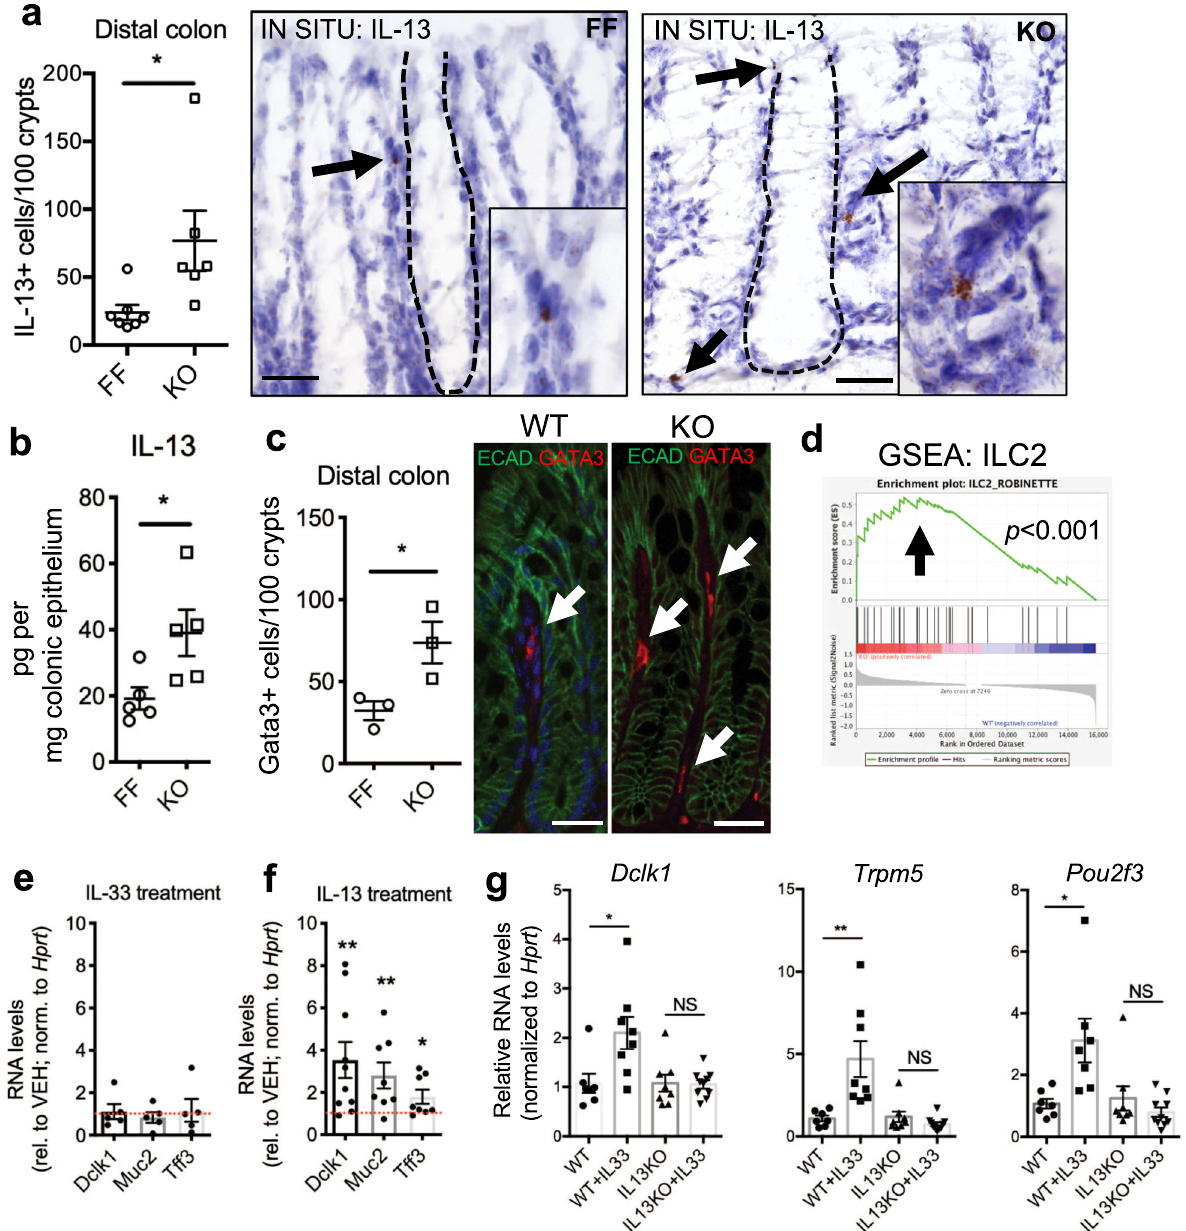
Fig. 4 IL-33-driven tuft and goblet cell expansion requires stromal IL-13. a Distal colonic sections from Spry2 FF and Spry2 IEKO mice were probed for Il13 by in situ RNAscope analysis and counted for IL-13 + cells per 100 crypts (dashed line around colonic crypt at base of epithelium); n = 7 FF, 6 KO mice; * p = 0.0301. Scale bar = 25 µ m. b Epithelial scrapings from Spry2 FF and Spry2 IEKO mice were measured for IL-13 levels by ELISA; n = 5 per group; * p = 0.0338. c Number of Gata3 + cells was quanti fi ed in distal colonic tissue. Gata3 = red, E-cadherin = green; n = 3 per group; * p = 0.0409. Scale bar = 25 µ m. d Gene set enrichment analysis (GSEA) using a published intestinal ILC2 gene signature from bulk tissue 31 was performed on RNA sequencing of distal colonic homogenates; n = 6 per group. Colonoids generated from WT mice were treated with e IL-33 (100 ng/ml, n = 5 cultures per group) or f IL-13 (10 ng/ml, n = 8 cultures per group) for 24 h, and analyzed for tuft ( Dclk1 ) and goblet cell ( Muc2, Tff3 ) marker expression. Each colonoid culture was from a different mouse. * p < 0.05; ** p < 0.01. g WT and IL-13 − / − mice were i.p. injected with PBS or IL-33 for 4 days, and distal colonic expression of tuft cell markers ( Dclk1 , Trpm5 , and Pou2f3 ) was assayed by qPCR, revealing a requirement for IL-13 in IL-33 mediated tuft cell induction in the colon; n = 7 WT + PBS, 8 WT + IL-33, 8 IL-13KO + PBS, and 10 IL-13KO + IL-33. * p < 0.05; ** p < 0.01. Data are presented as mean ± SEM. Analyzed by a – f two-sided t test or g one-way ANOVA with Tukey post hoc